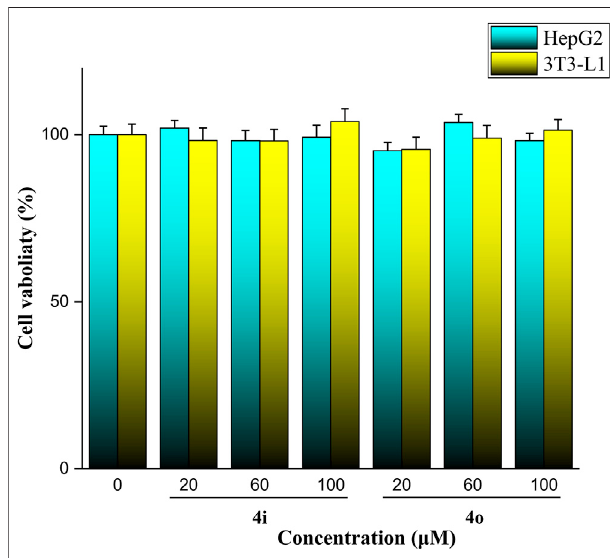
FIGURE 5 | Cell cytotoxicity of analogs 4i and 4o against HepG2 and 3T3-L1 cells.